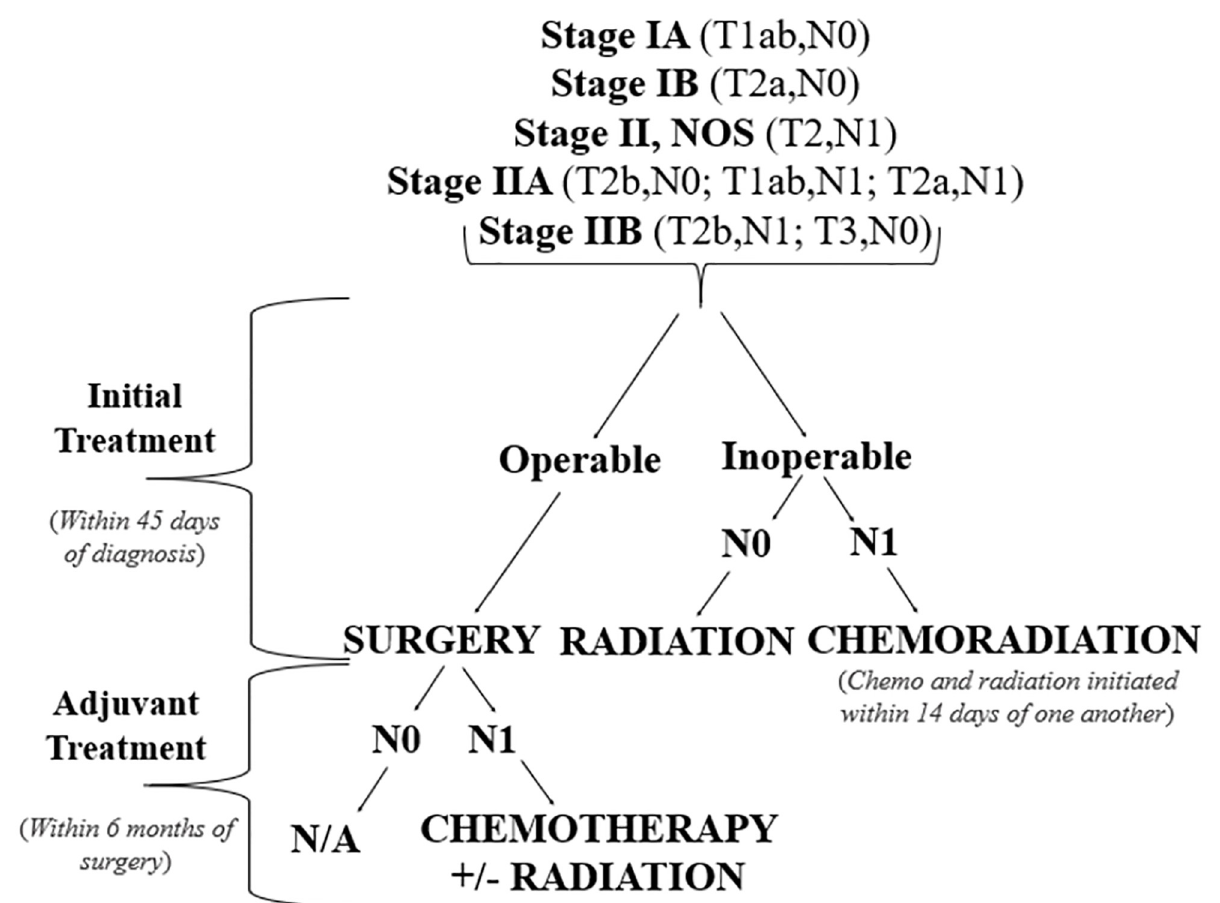
Fig 1. NSCLC GCT based on NCCN guidelines. NSCLC recommended treatment according to the 2016 NCCN guidelines. For stage 1A-IIB NSCLC, an operable patients’ initial treatment should be surgery within 45 days of diagnosis. If the patient is node 1 (N1), adjuvant treatment of chemotherapy +/- radiation should be administered within 6 months of surgery. For inoperable patients, initial treatment differs by lymph node involvement. If the patient is node 0 (N0), initial treatment should be radiation within 45 days of diagnosis. If the patient is node 1 (N1), initial treatment should be chemoradiation within 45 days of diagnosis. If a patients’ chemotherapy and radiation start date are within 2 weeks of one another, this will be considered chemoradiation.